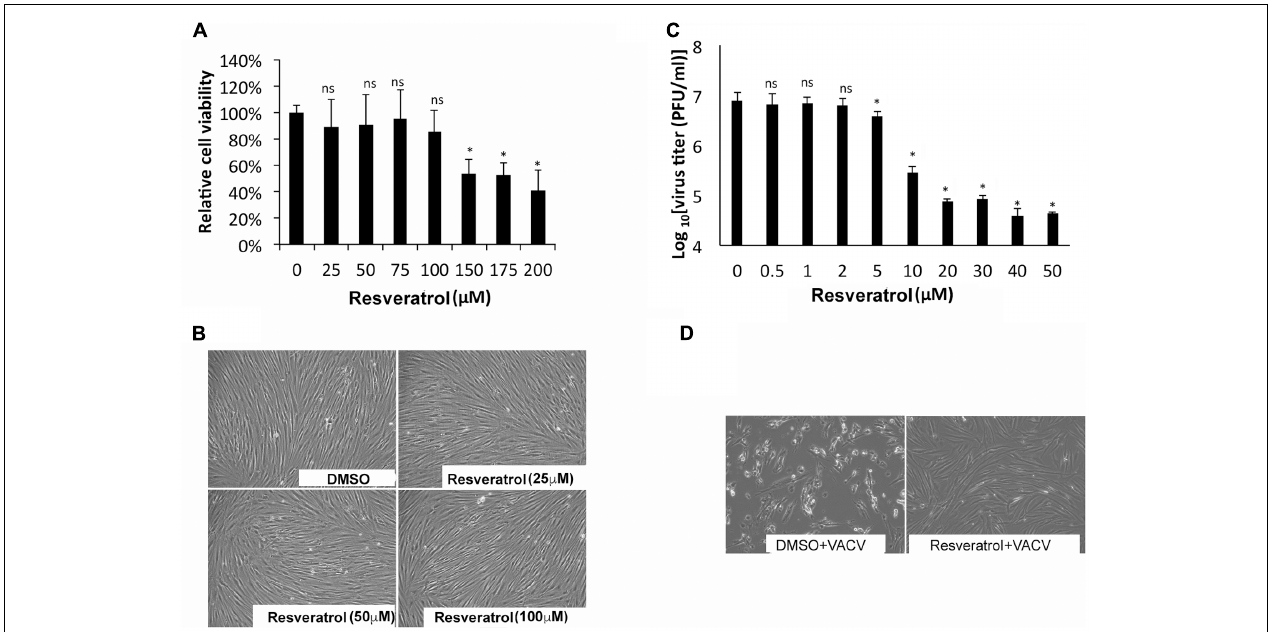
FIGURE 2 | Resveratrol suppresses VACV replication in HFFs. (A) HFFs were treated with DMSO or resveratrol at the indicated concentrations for 24 h. Cell viability was measured using trypan blue exclusion test. (B) DMSO- or resveratrol-treated cells were imaged under the bright field of a microscope. (C) HFFs were infected with VACV at an MOI of 1 in the presence of resveratrol at the indicated concentrations. Virus yield at 24 hpi was determined by a plaque assay. (D) HFFs were infected with VACV at an MOI of 0.01 in the presence of resveratrol at the indicated concentrations. At 72 hpi, cells were imaged under the bright field of a microscope. The asterisk indicates significant difference ( P < 0.05) and the ns indicates no significant difference between DMSO-treated cells and resveratrol-treated cells. The error bar indicates standard